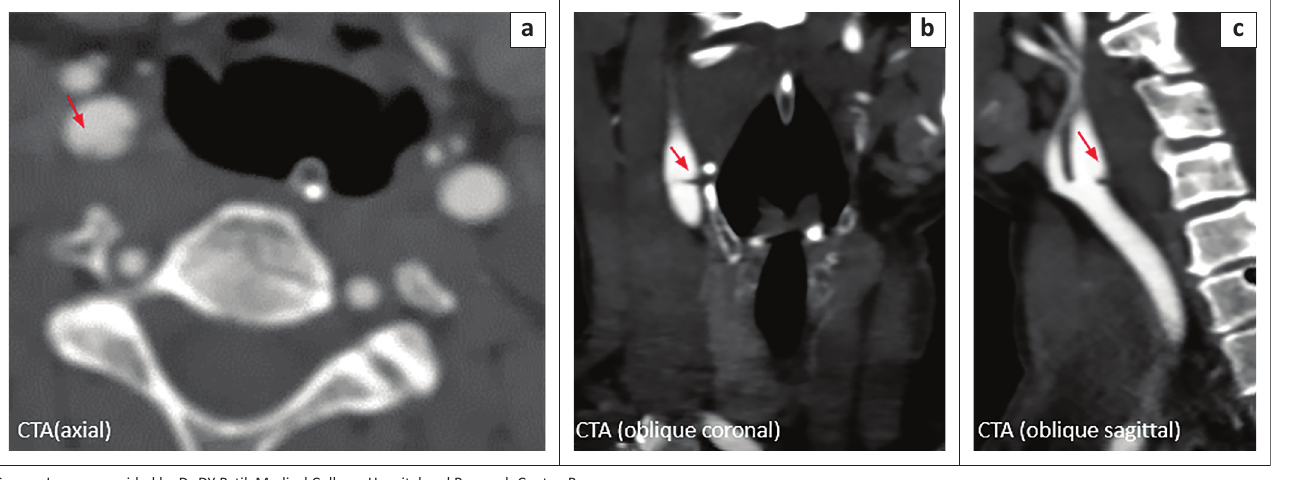
FIGURE 3 : Axial (a) computed tomography angiography (CTA) demonstrating a subtle linear flap (arrow) at the posterior wall of right ICA origin. Oblique (b) and sagittal (c) reformats of the CTA indicating a distinct shelf-like 2 mm thickness filling defect, protruding into the right ICA lumen from the posterior wall, at its origin, suggestive of a carotid